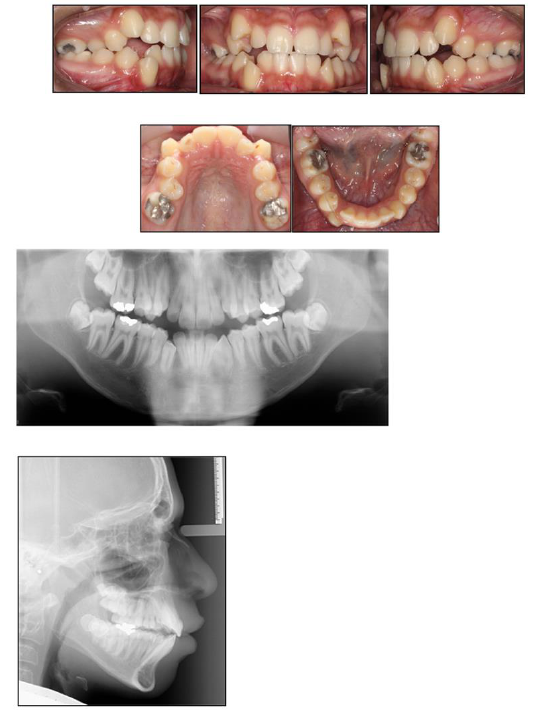
Figure 1. Pre-treatment intraoral photographs and radiographs.